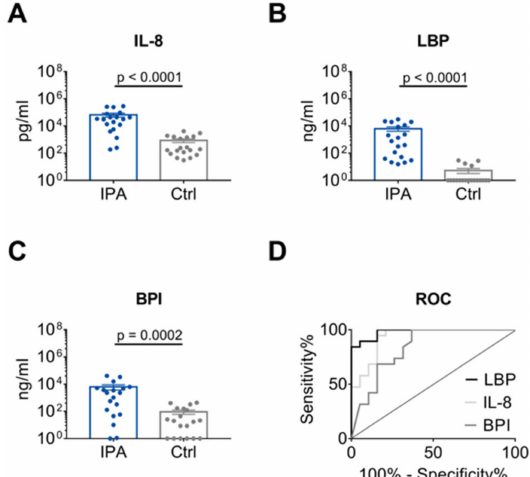
Figure 2. Distinction of IPA and Ctrl patients by IL-8, LBP and BPI. ( A – C ) Levels of IL-8, LBP and BPI in the BALF of 19 patients with IPA compared with 19 age- and sex-matched Ctrl patients. Data are presented as mean ± SEM. P -values were determined by Mann-Whitney U test. ( D ) AUC as determined by ROC curve analysis for IL-8, LBP and BPI values depicted in ( A – C ) for IPA and Crtl